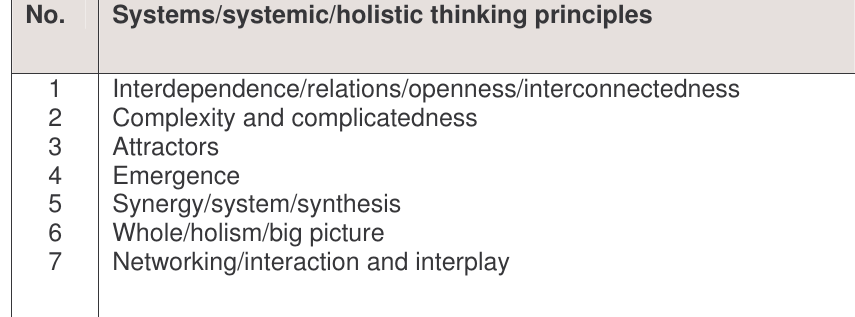
Source : Adapted from Mulej et al. (2004: